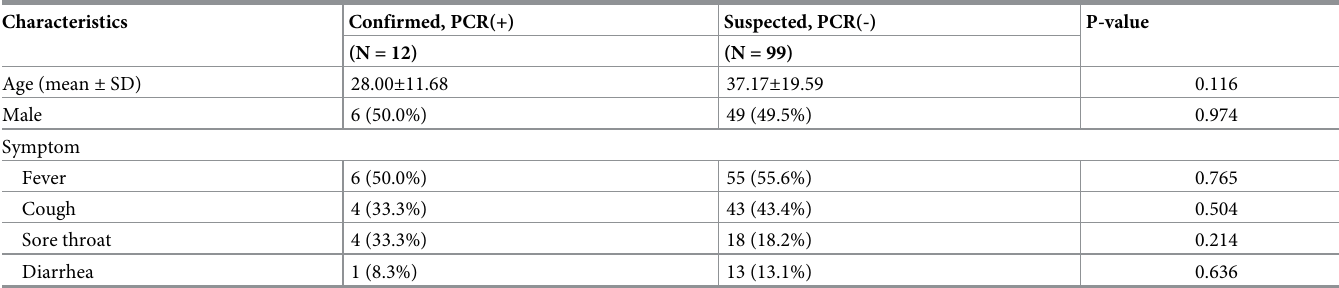
Table 1. Essential demographic characteristics of participants.